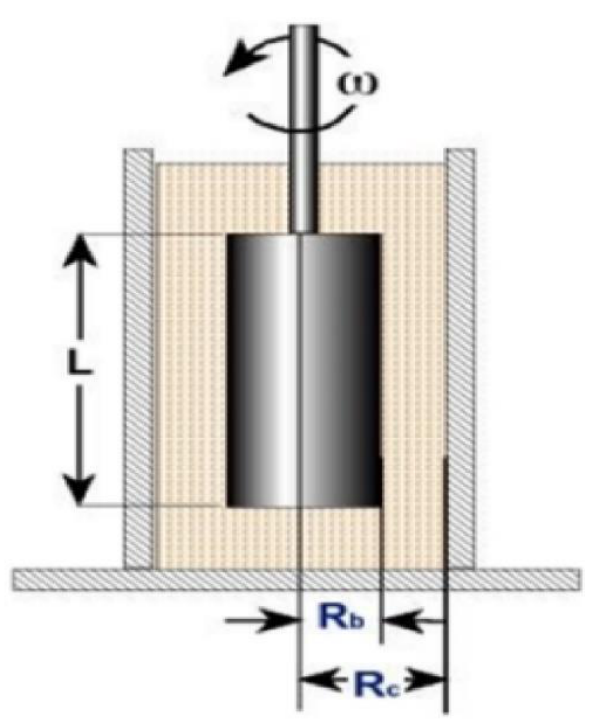
Figure 10. Viscometer dimension.